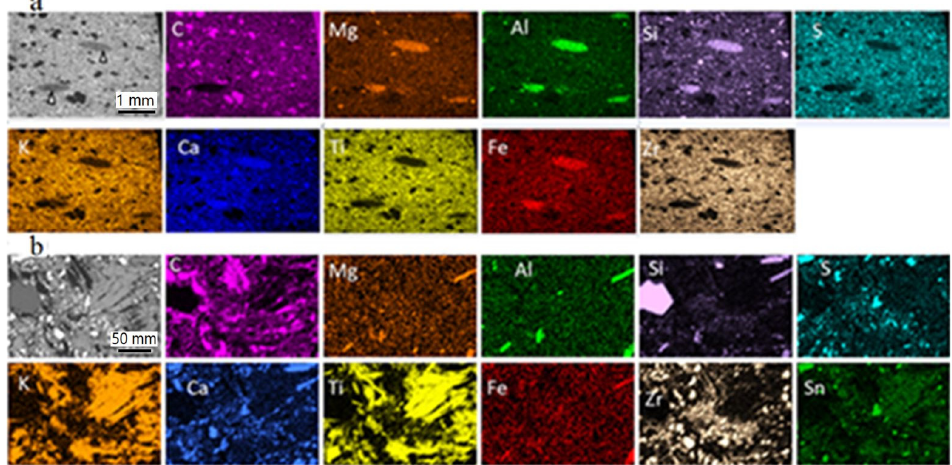
Figure 5. BSE-SEM images (grey) and element mapping illustrating the element distribution in the new brake pad. ( a ): Overview of the uppermost ~3 mm of the pad profile (side view); grey lenticular parts (pointed by arrows) correspond to fiber-rich pockets; ( b ): detail of the pad surface (top view) showing ‘large’ and finer matrix constituents; in addition to the depicted elements, smaller amounts of Ba, Na, Sn (in a ) and Bi (in b ) were analyzed. The color intensity increases with the element concentration and thickness. Both samples were impregnated and polished. Table 1. Particle types in the new brake pad: morphology, qualitative chemical composition and corresponding (presumed) mineral phases.